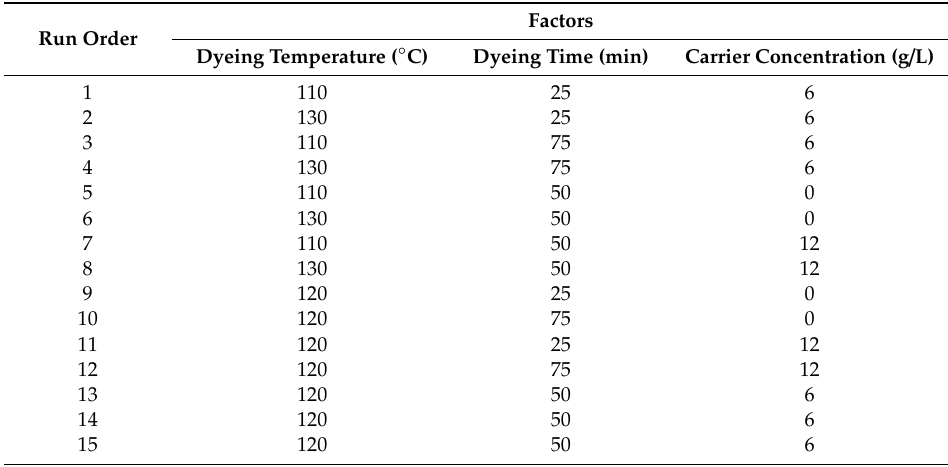
Table 4. The three-level Box-Behnken experimental design used in this